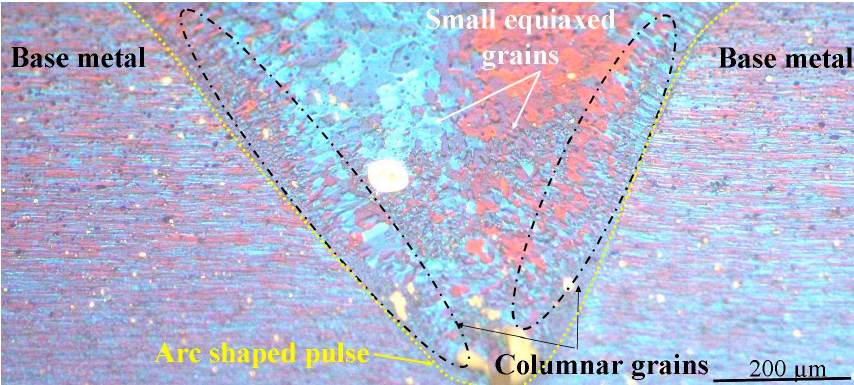
Figure 1. As-cast structure of the welded seam of the Al-4.7Mg-0.32Mn-0.21Sc-0.1Zr alloy.